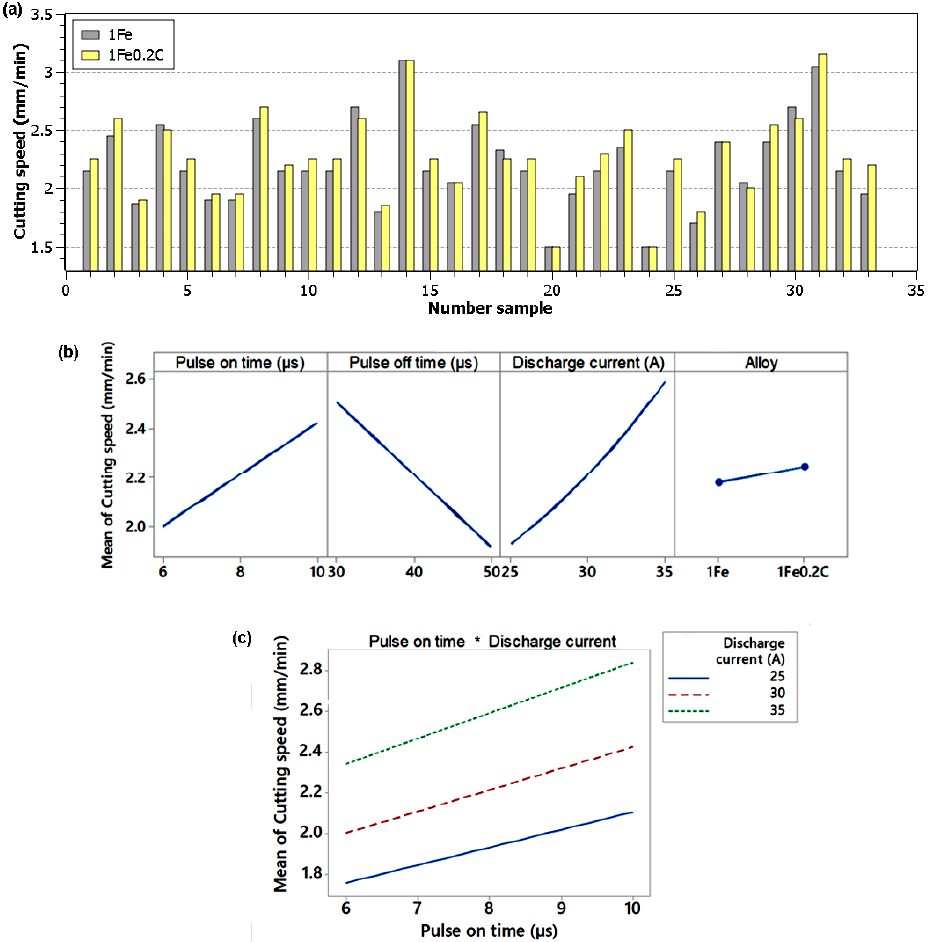
Figure 2. ( a )The cutting speed of individual samples of 1Fe and 1Fe0.2C material, ( b ) the main e ff ect plot for cutting speed, ( c ) the interaction plot for cutting